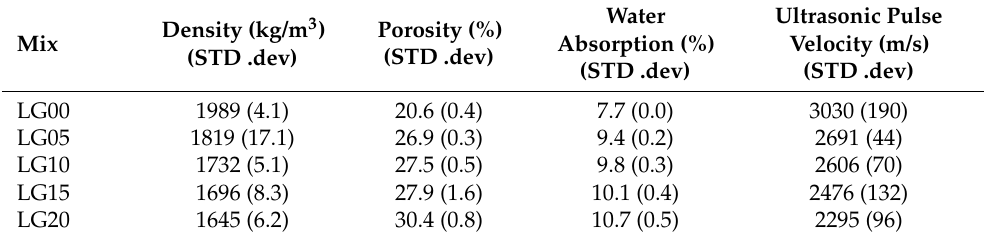
Table 5. Dry density, porosity, water absorption, and ultrasonic pulse velocity of geopolymer mortar containing